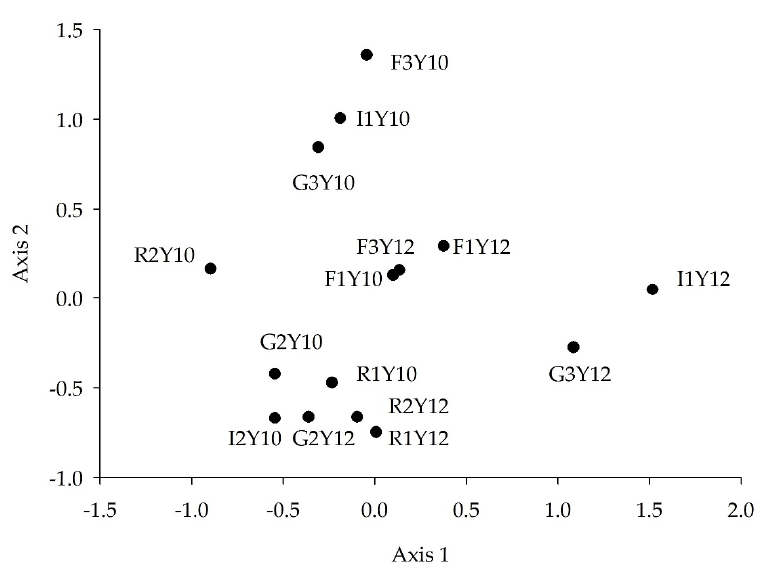
Figure 6. Axis 1 versus 2 (58% variance explained) reach sampling event distribution of the non- metric multi-dimensional scaling analysis of FWI assemblages at 8 land use/land cover sites in 2010 and 7 sites in 2012 (F = Forest, G = Golf, I = Industrial, R = Residential; Y10 = 2010, Y12 = 2012).